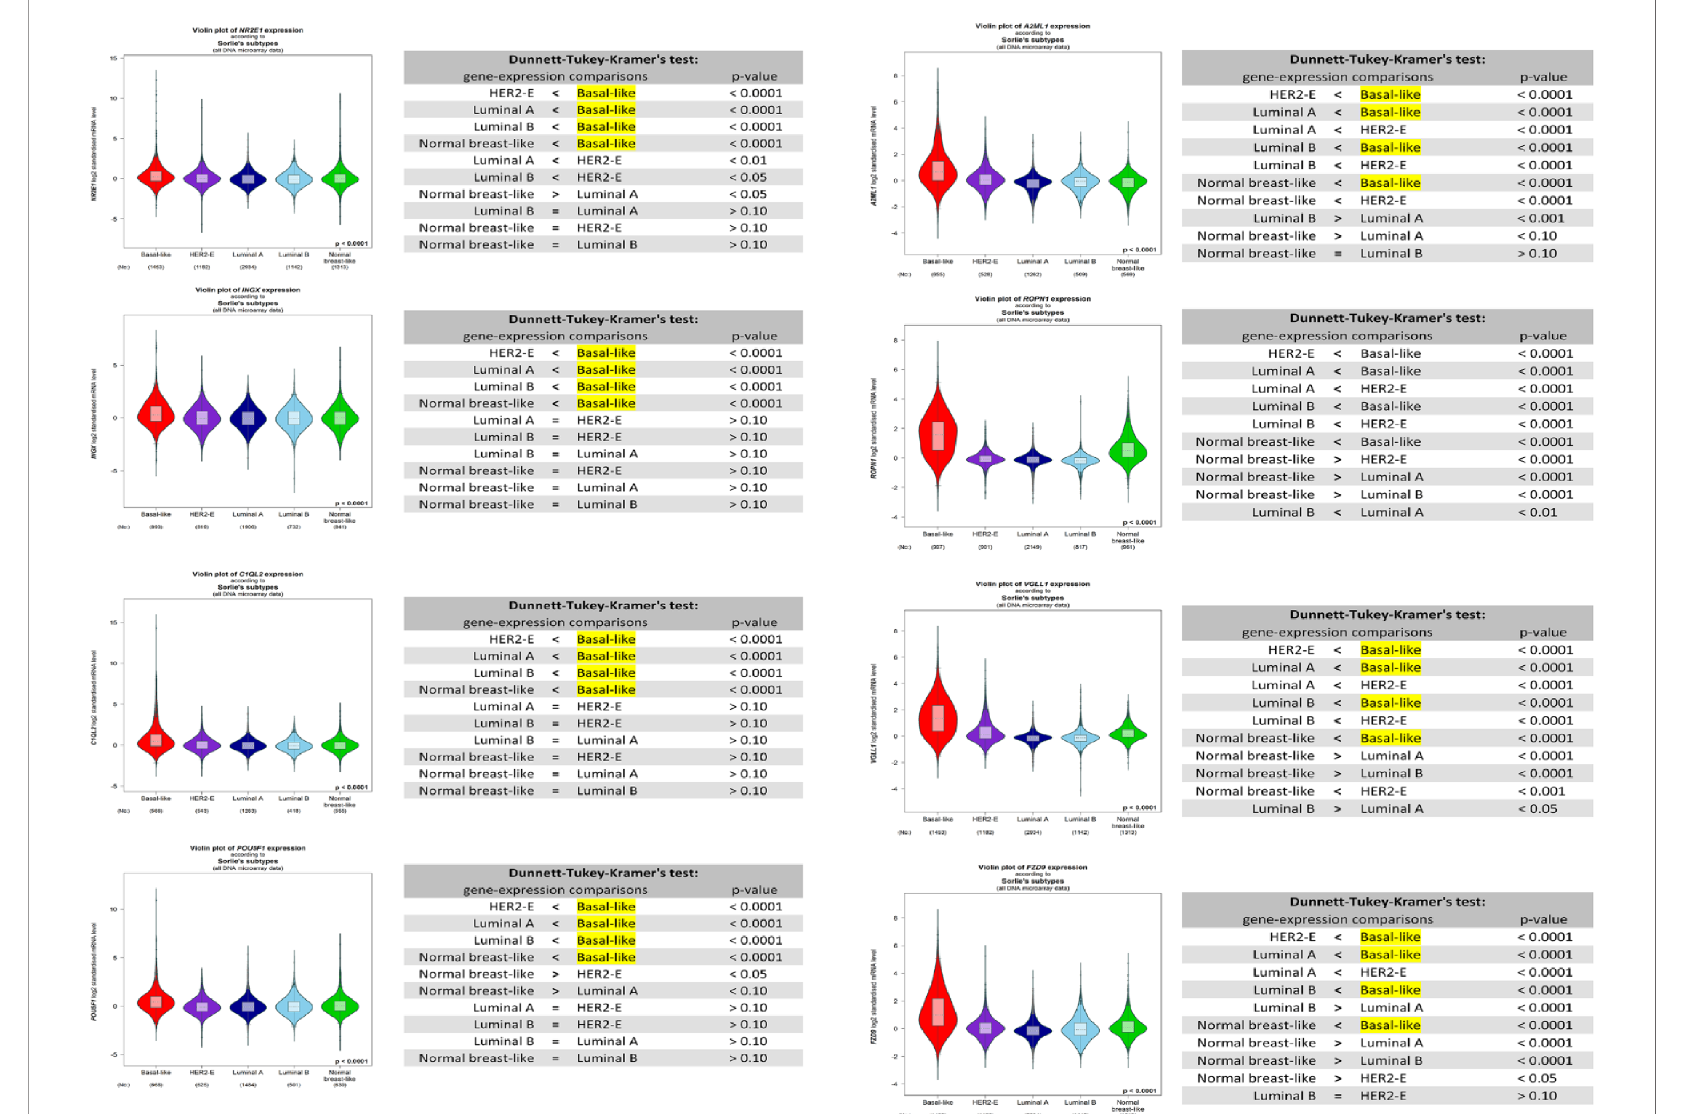
FIGURE 4 | Box plot of NR2E1, INGX, C1QL2, POU5F1, A2ML1, ROPN1, VGLL1, FZD9 expression in different breast cancer subtypes using Breast Cancer Gene-Expression Miner v4.0